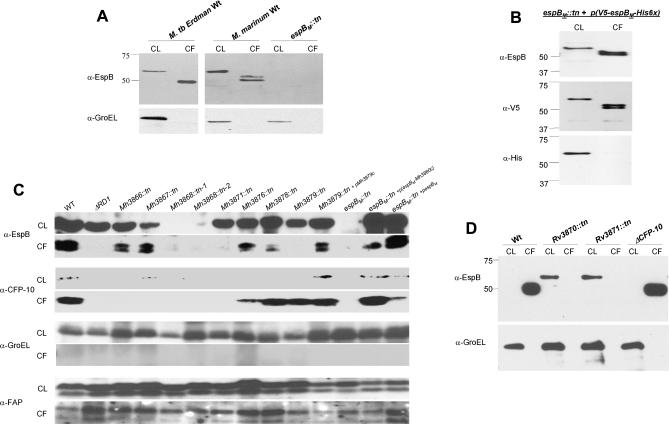
Requirements for EspB Secretion in M. marinum and M. tuberculosis
Cell lysates (CL) and culture filtrates (CF) were prepared from the indicated strains as described in Materials and Methods. Proteins were separated by SDS-PAGE, and the indicated proteins were detected by western blot as described in Materials and Methods.(A) 60 μg of total CL and 30 μg of total CF of M. tuberculosis Erdman and each of the M. marinum strains were loaded in each well.(B) 60 μg of total CL and 30 μg of total CF were loaded in each well.(C) Cultures of each strain were grown in 7H9 to an OD of 0.5 and then inoculated into Sauton's medium at an OD of 0.5 and grown for 36 h. Therefore, the samples of each strain are normalized by OD readings. Of the total CL and CF fractions collected for each strain from one experiment, 3% of the CL was loaded in each lane and 15% of the total CF was loaded into each lane. The results shown are representative of the results obtained in four replications of this experiment.(D) 30 μg of total CL and 30 μg of total CF of each M. tuberculosis Erdman strain were loaded in each well.